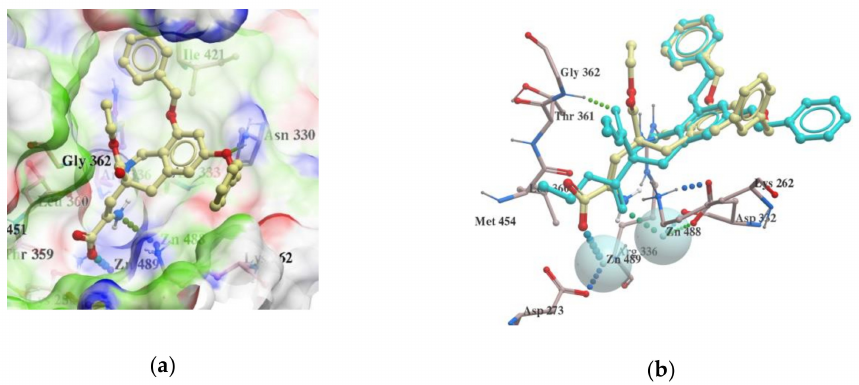
Figure 4. ( a ) interactions of LAP active site residues with the compound {[6,8-(dibenzyloxy)-3- (ethoxycarbonyl)-3,4-dihydroisoquinolin-3-yl]oxy}acetic acid with the best docking score (–38.66). ( b ) interactions of LAP active site residues with the compound {[6,8-(dibenzyloxy)-3-(ethoxycarbonyl)- 3,4-dihydroisoquinolin-3-yl]oxy}acetic acid in comparison to docking pose of diethyl 6,8-dibenzyloxy- 3,4,-dihydroisoquinoline-3,3-dicarboxylate (shown in